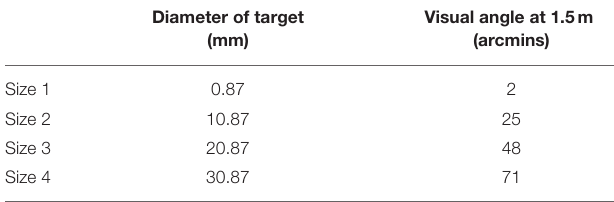
TABLE 1 | Target sizes.